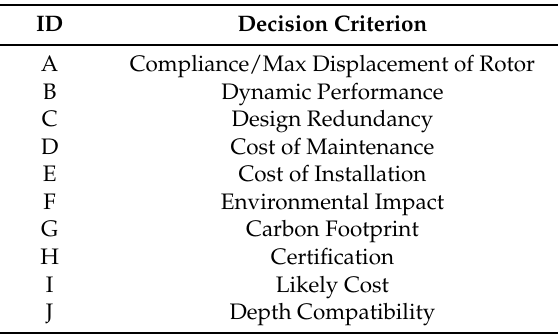
Table 2. List of criteria.